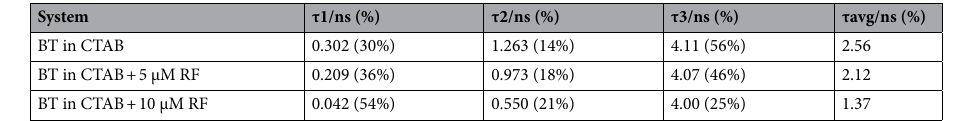
Table 1. Time-resolved decay parameters of BT in CTAB in absence and in presence of RF at two different